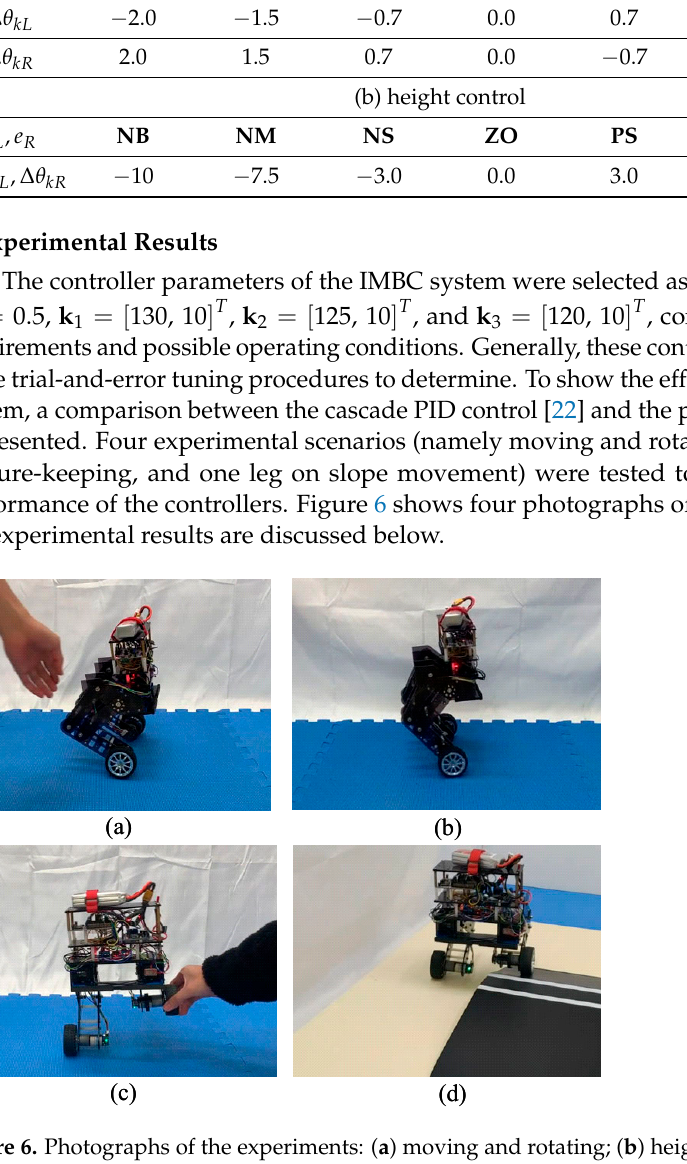
Figure 6. Photographs of the experiments: ( a ) moving and rotating; ( b ) height-changing; ( c ) posture- keeping; ( d ) one leg on slope movement.